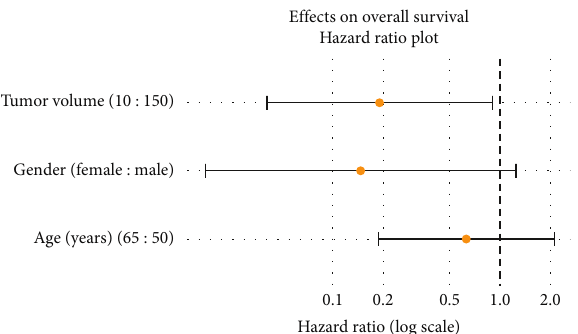
Figure 2: Plot of hazard ratios (95% confidence intervals) for overall survival.